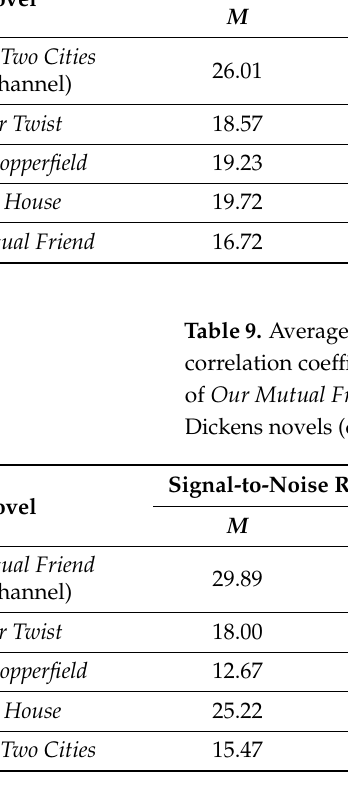
Table 5, in the cross-channel of David Copperfield , Γ dB , ex = 18.18 ± 3.98 (dB), while, from Table 6, in the cross-channel of Oliver Twist , Γ dB , ex = 17.87 ± 2.63